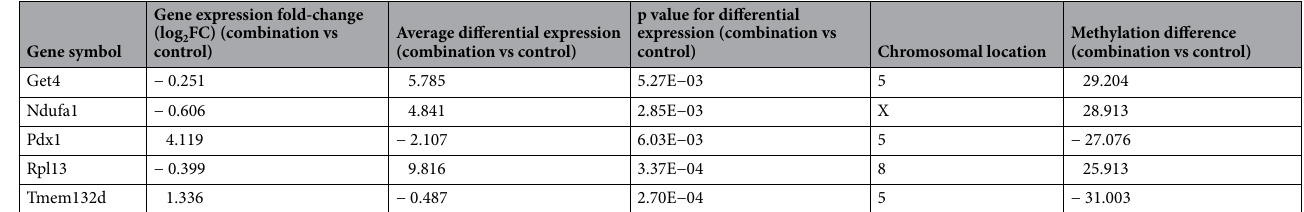
Table 4. Target genes with positive correlation with gene expression and DNA 860 methylation changes in the combination (BSp + GTPs) treatment